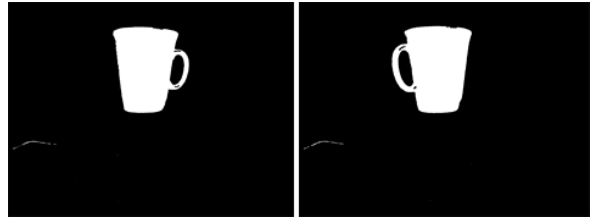
Figure 3. Examples of the binary images of the background and foreground segments